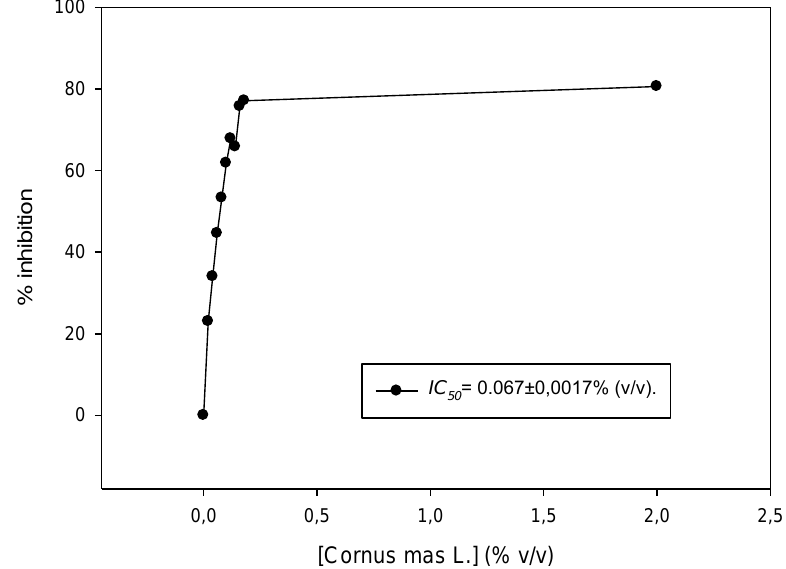
Figure 1. DPPH (2,2-Diphenyl-1-picrylhydrazyl) radical scavenging activity of Cornus mas L. juice. Increasing concentrations of the juice (0.02–0.2% v/v ) were incubated in the presence of DPPH for 30 min. Representative figure of at least three independent experiments.